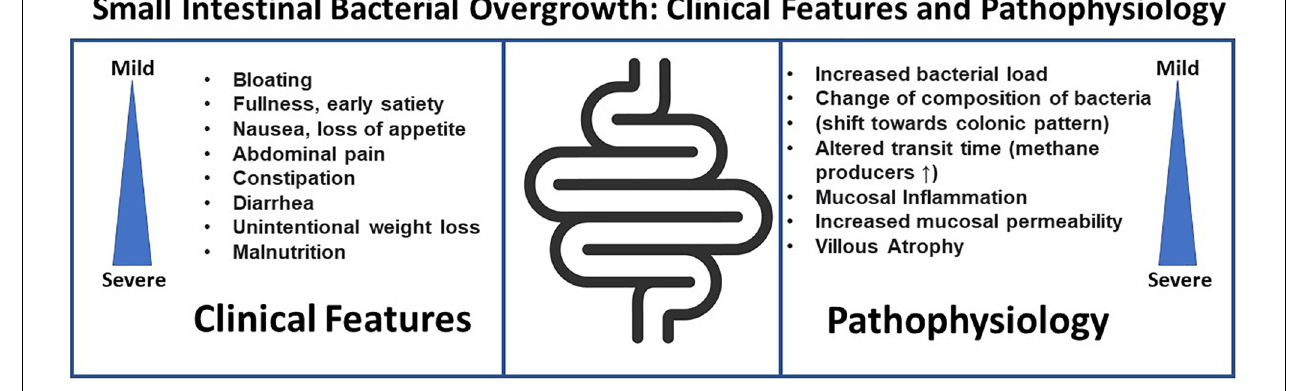
FIGURE 1 | Small intestinal bacterial overgrowth, clinical features and